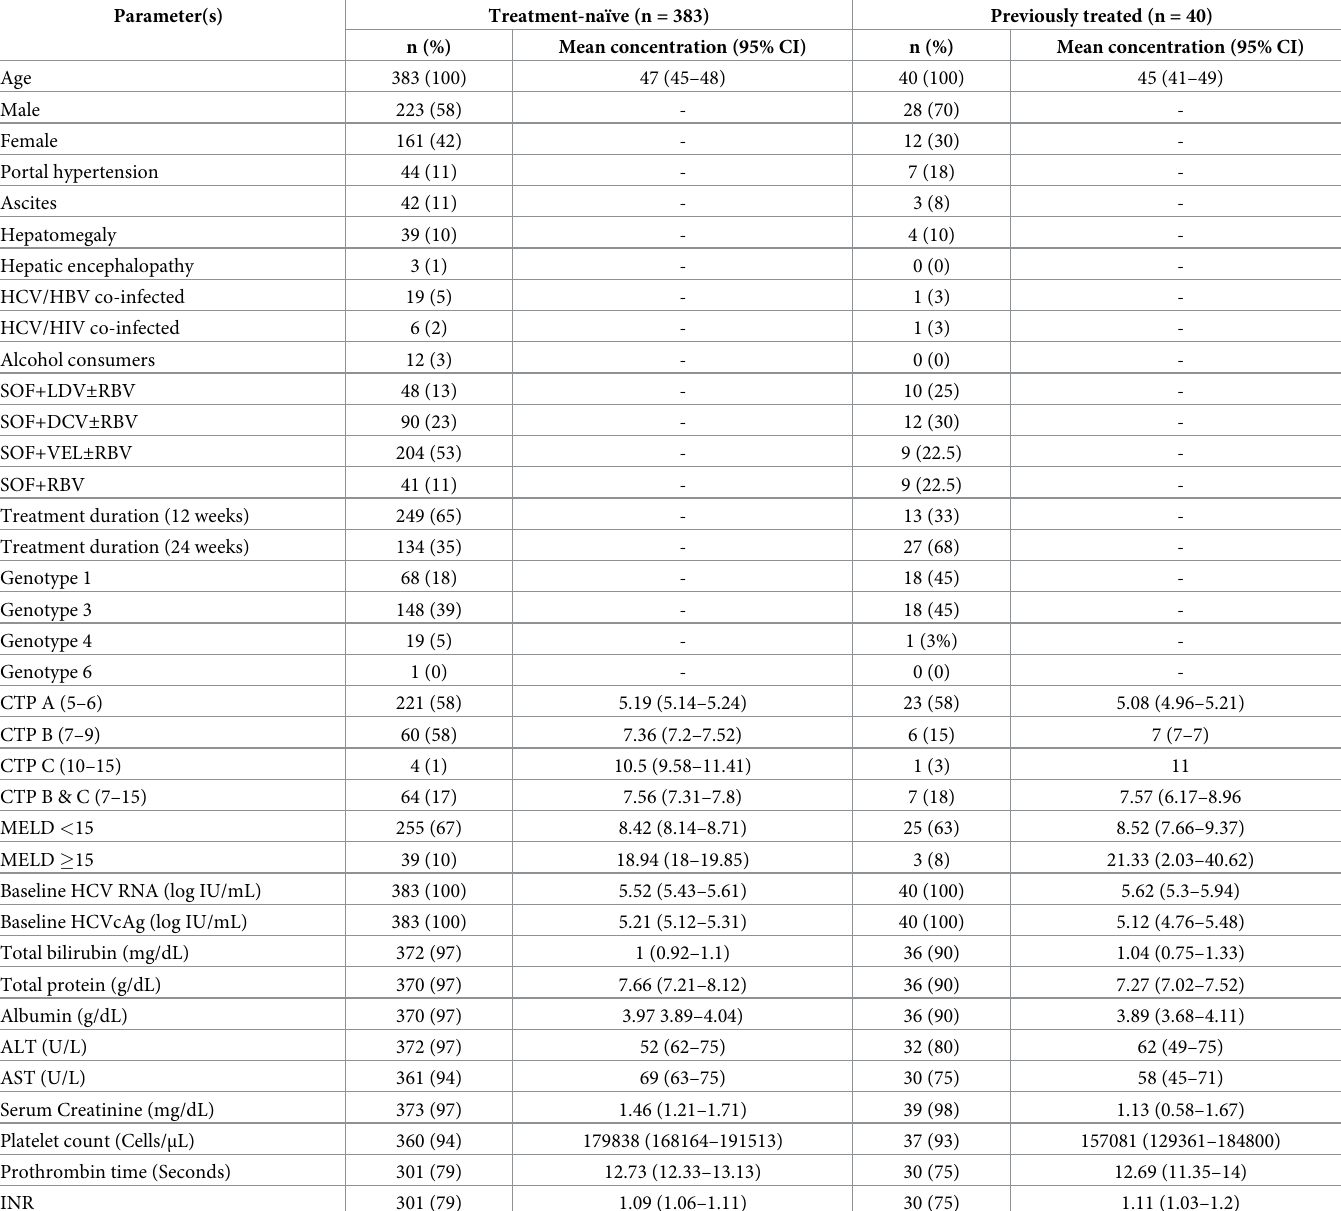
Table 1. Baseline demographic, clinical and virological characteristics of 423 study patients.